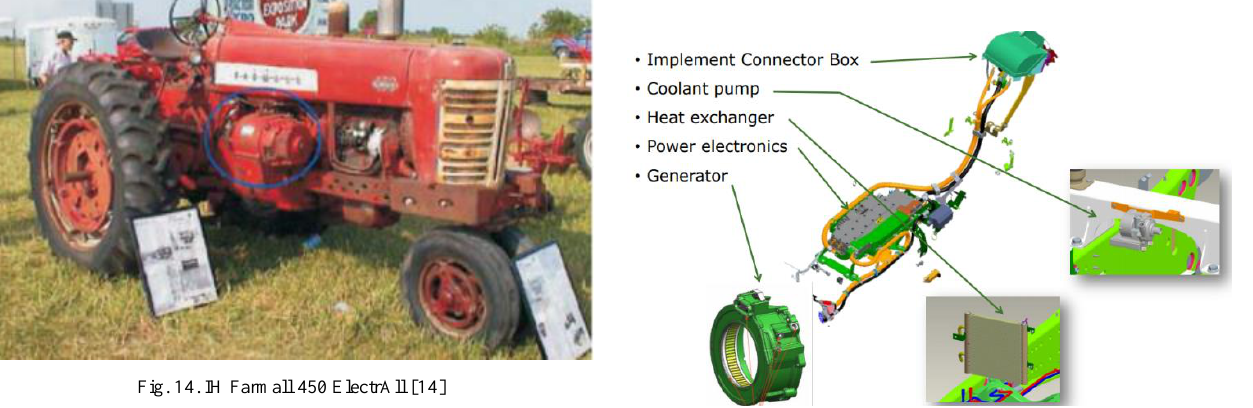
Fig. 15. John Deere 7530 E Premium components [30, 33] Again, John Deere repeated similar solution and ex- panded its capabilities in 2011with model 6210 RE. This time architecture was similar to the solutions from 2007 however now 20 kW of electric power was available for driving external machines also when tractor was moving (Fig. 16). Available electric power parameters were 480 V DC and 3-phase, of 750 V AC with max. current of 200 A [13, 15, 30, 31].